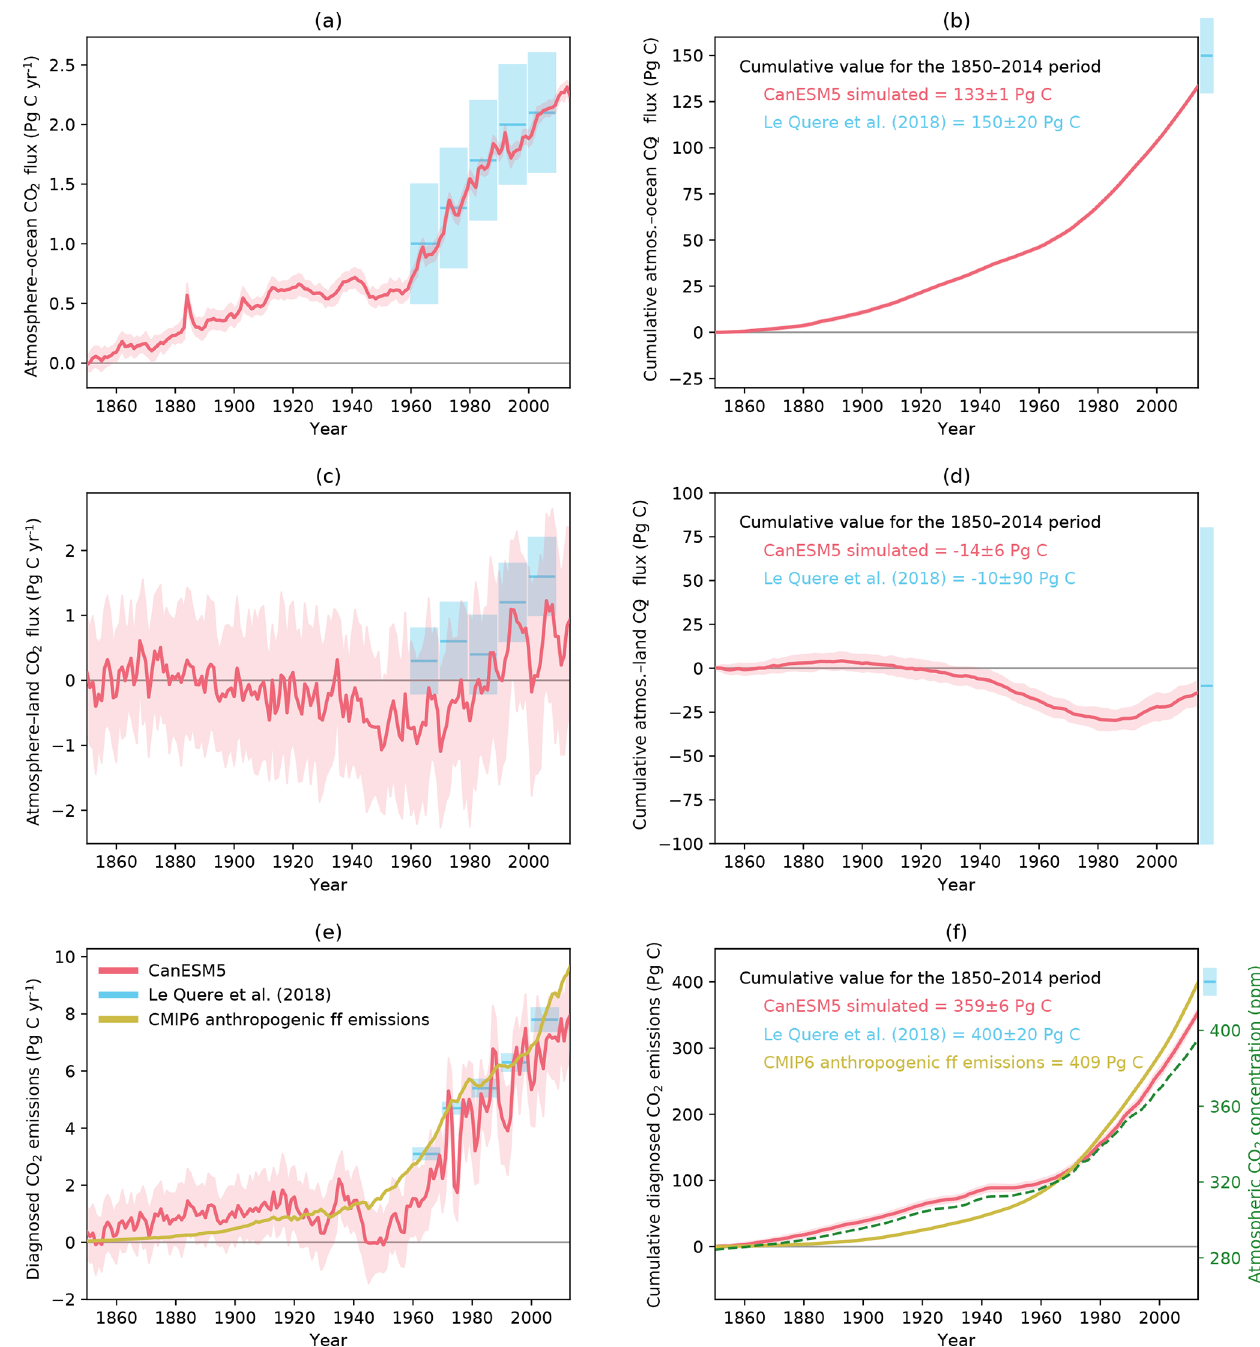
Figure 28. Annual (a, c, e) and cumulative (b, d, f) global values of simulated atmosphere–ocean and atmosphere–land CO 2 fluxes, and diagnosed anthropogenic fossil fuel emissions, shown in blue colour. The model values are shown as mean ± 1 standard deviation range and calculated based on the 25 ensemble members of the historical simulation. Model values are compared against estimates from Le Quéré et al.